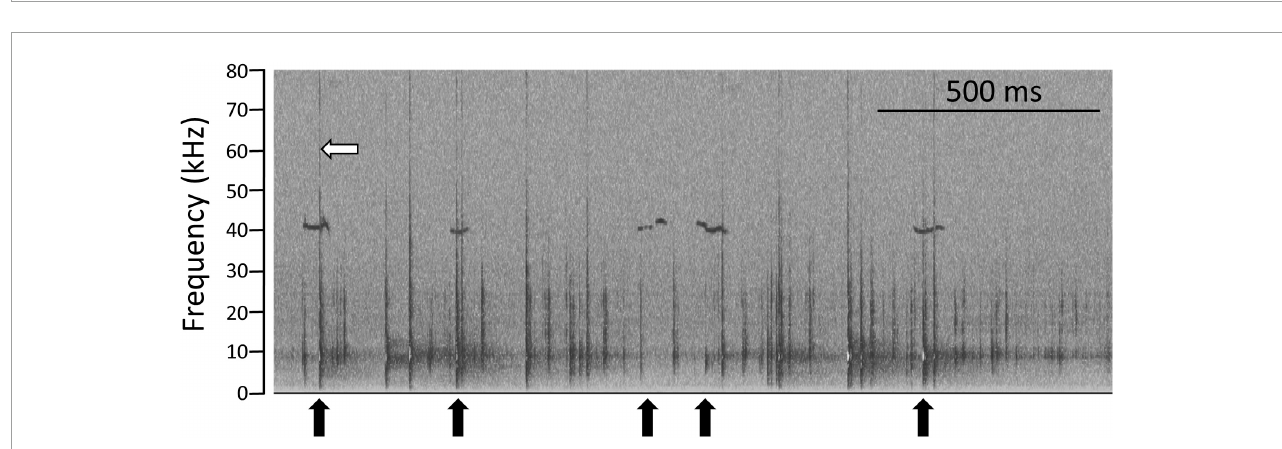
FIGURE2 Identification of flat USVs associated with chewing food pellets. Spectrogram representing the frequency of sounds recorded with the ultrasonic microphone, while a rat was eating food pellets. When rats chewed food, the breakage of pellets produced a sound across all frequencies, in the form of the vertical lines (for example white arrow). In this illustration, rats produced flat USVs (horizontal) at around the frequency of 40 kHz, sometimes while chewing pellets (black arrows). Horizontal scale bar represents 500